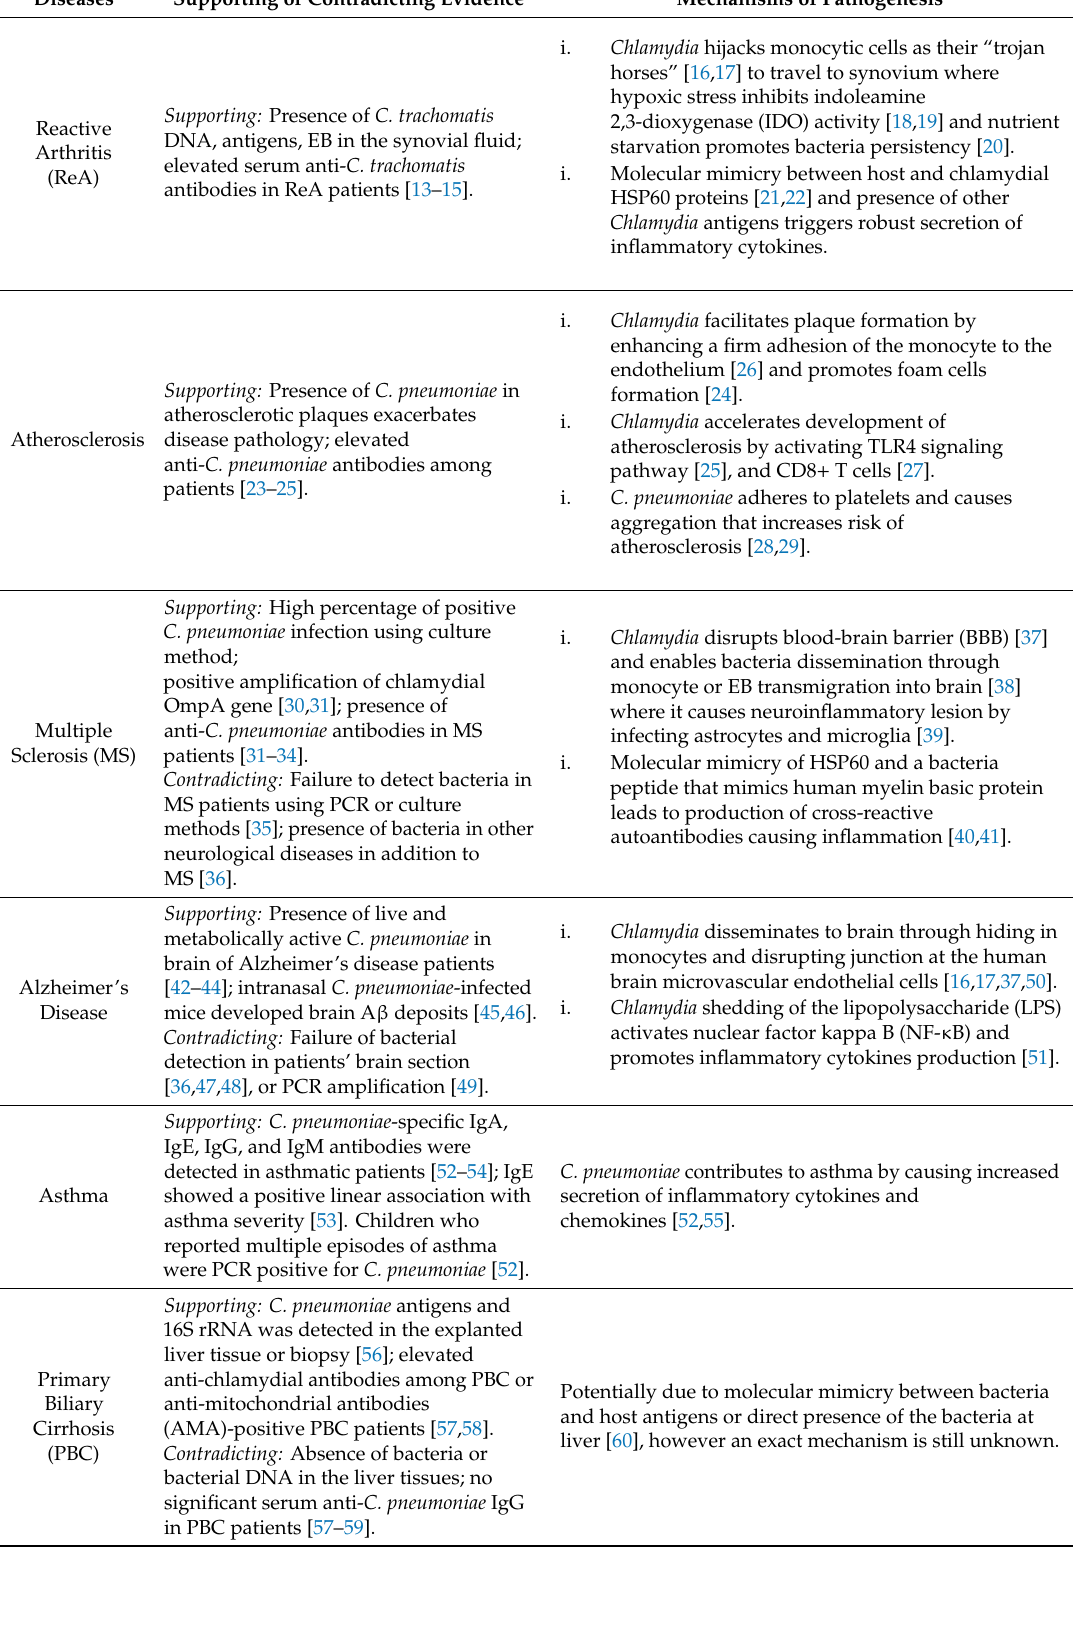
Table 1. The list of chronic inflammatory diseases associated with infection by the Chlamydiaceae family.